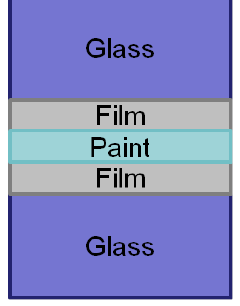
Fig. 7 Paint directly applied on glass Fig. 8 Paint between two layers of